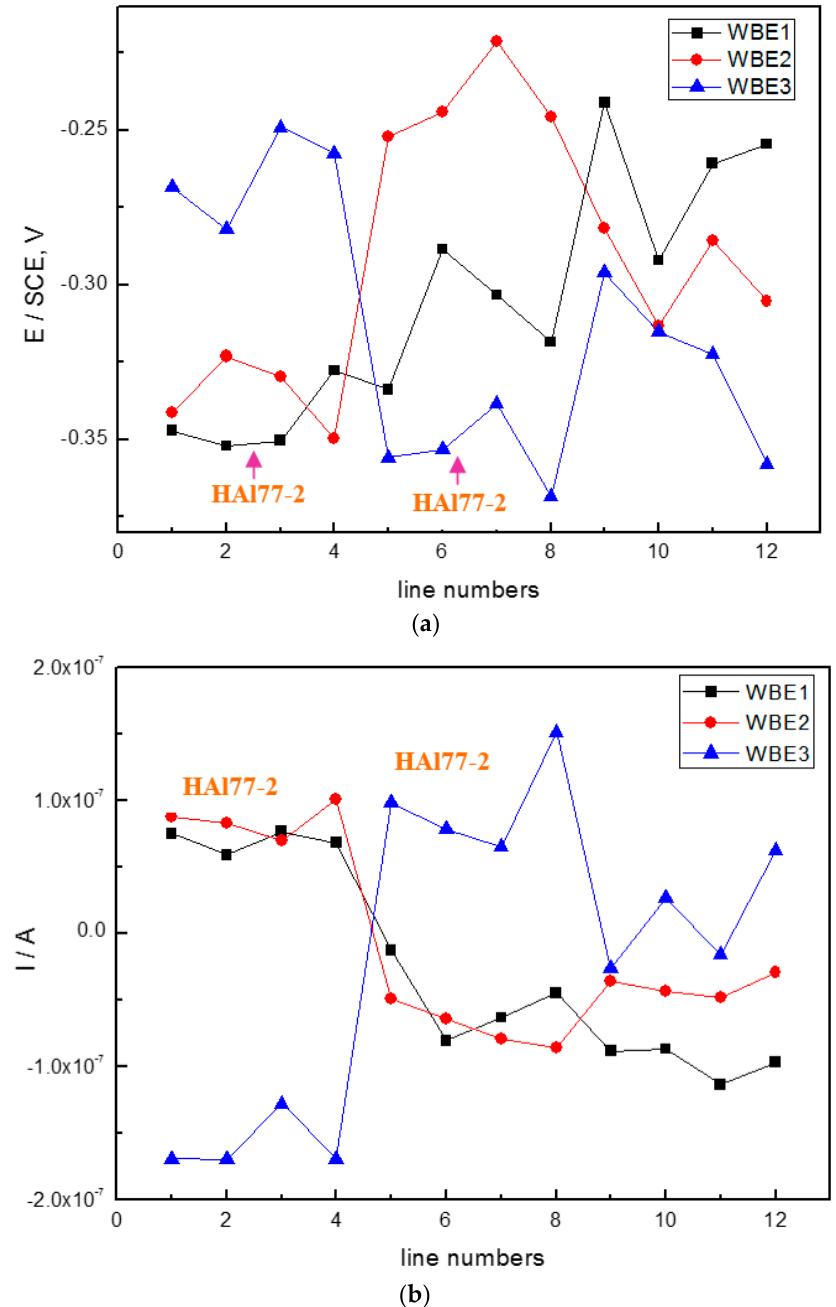
Figure 18. ( a ) Average potential; and ( b ) current–density distributions of each microelectrode line after being short-circuited for 12 h in artificial seawater with 1.5 wt % Cl − at 30 °C.